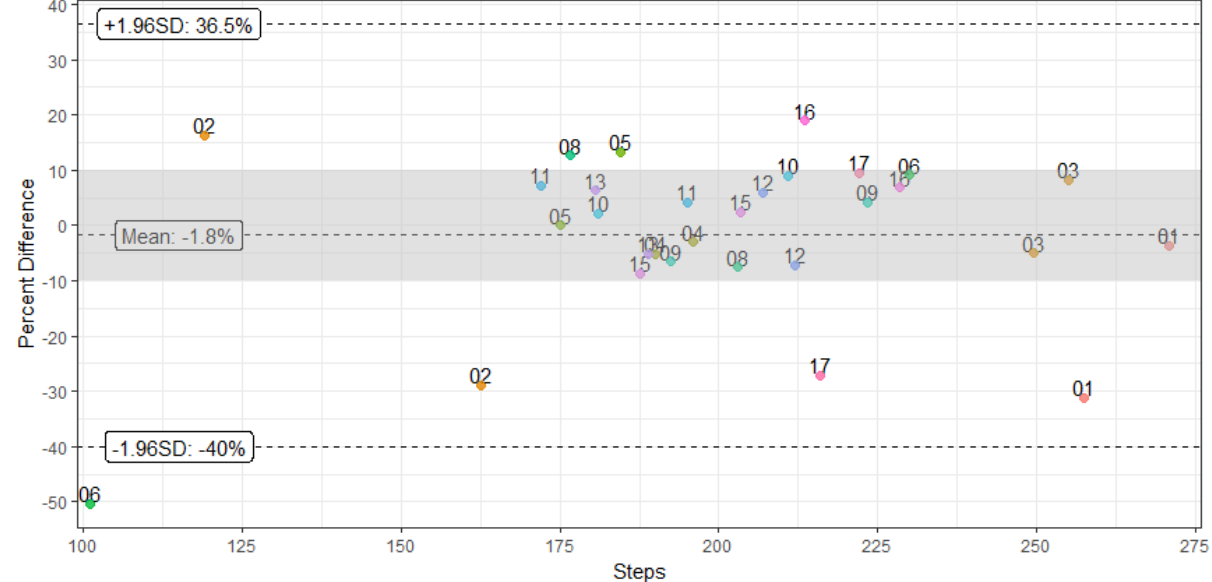
Figure 2. Bland Altman plot of accuracy of step activity monitor step counts compared to manual counts. Percent difference between Fitbit and manual step counts (y-axis) versus the manual step counts (x-axis). Each participant had 2 trials. The shaded region represents the “acceptable” range of error (10% in either direction), while dotted lines depict the mean percent difference and their 95% confidence intervals. Participants 2, 6, and 8 used a cane for ambulation, but no ambulatory assistance devices were used during gait